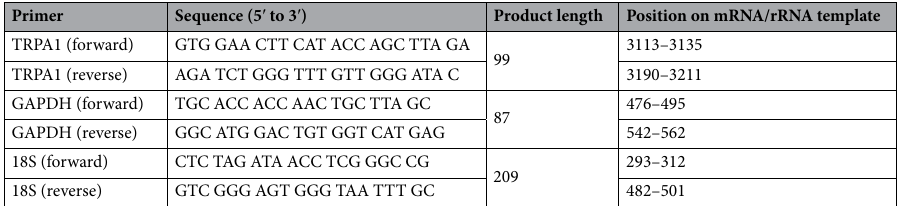
Table 1. Sequences of primers used in qPCR analysis. Primer pairs were designed using the NCBI Primer- BLAST